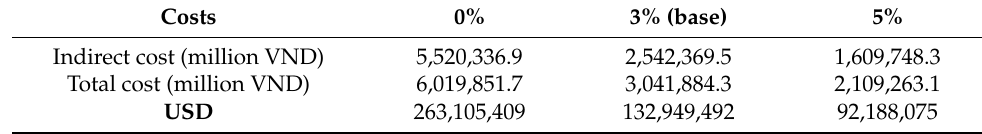
Table 5. One-way sensitivity analysis of cost of colorectal cancer, applying the discount rate 0% and